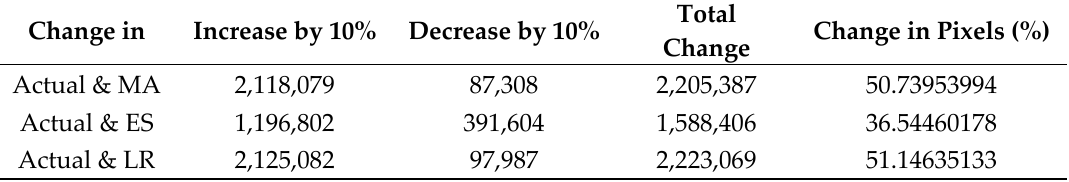
Table 2. Change detection in percentage of actual image with forecasted images of the year